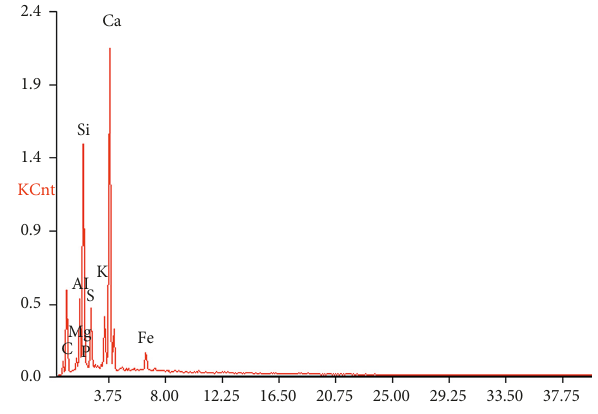
Figure 13: Elemental analysis